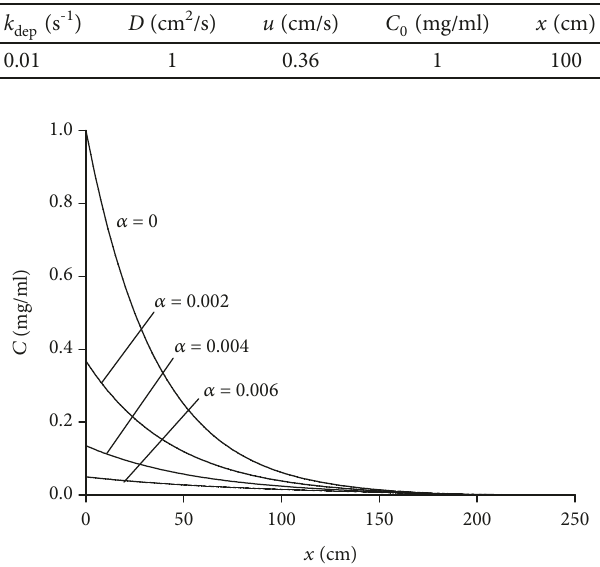
Table 6: Model parameters for simulations shown in Figure 7.